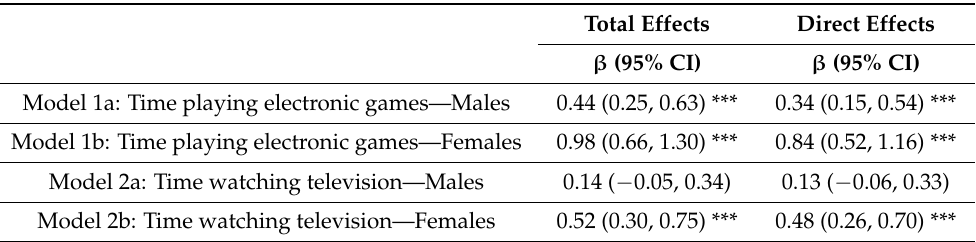
Table 2. The total and direct effects of electronic gaming and watching television on the psychological wellbeing of Australian male and female adolescents,